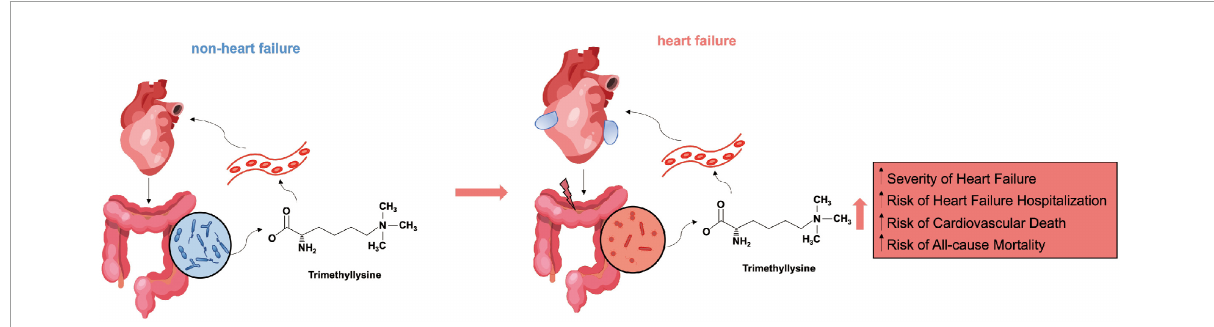
FIGURE4 Summary diagram outlining the proposed relationship between trimethyllysine (TML) and heart failure (HF). In non-HF conditions, TML synthesis and blood entry are minimal under the protection of the balanced intestinal flora and a healthy intestinal barrier. When HF occurs, the heart’s ability to pump blood decreases, the gut becomes congested and edematous, and the prevalent harmful bacteria, as well as the impaired intestinal barrier together, make TML easier to enter the bloodstream. Elevated circulating levels of TML are independently associated with the severity and poor prognosis of